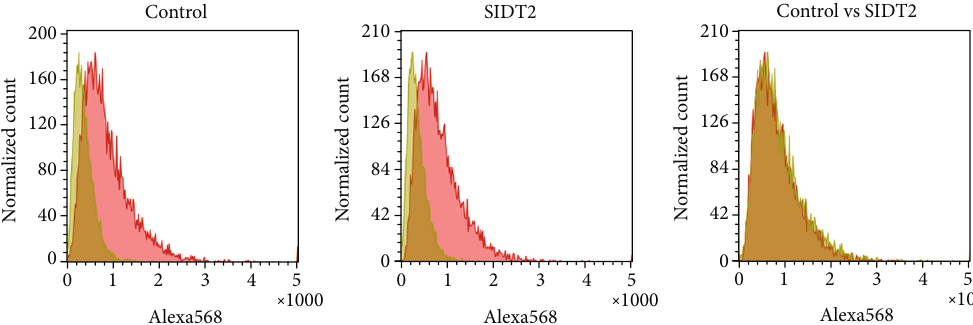
Figure 6: The SIDT2 level hardly a ff ects the total cellular uptake of naked A-15. MEFs were transfected with the empty plasmid (control) or pCI-neo-SIDT2 for 48 hours. Then, the cells were rinsed with PBS and cultured with or without 500nM of naked A-15. After the 24-hour culture, the cells were washed with PBS and analyzed with a fl ow cytometer. In the left and middle panels, yellow and red histograms are from MEFs cultured in the absence and presence, respectively, of A-15. In the right panel, the red histograms in the left and middle panels are overlaid and shown in yellow and red, respectively.